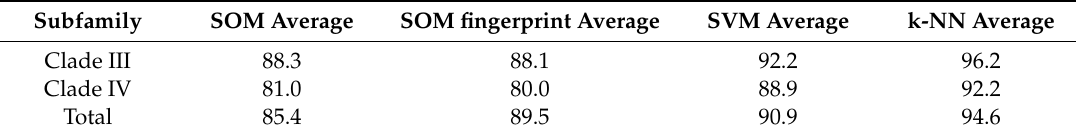
Table 4. Summary of test match (%) corresponding to the results obtained from 5-fold models using self-organizing map (SOM), support vector machine (SVM) and k-nearest neighbors (k-NN) algorithms for clade III (Nep) and clade IV (Aju + Lam + Scu).